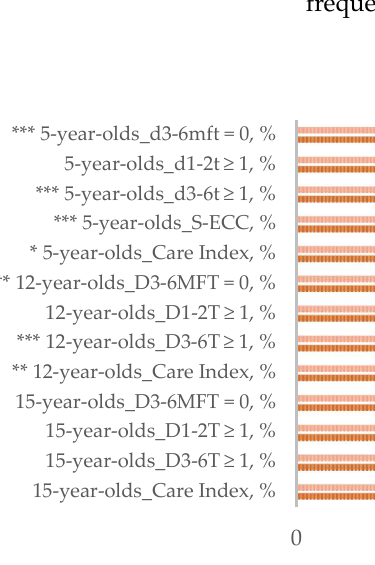
Figure 1. Caries prevalence of 5-, 12- and 15-year-old children and adolescents of immigrant origin in Greece, compared with their Greek age-mates. Percentage (%) with no caries experience at the defect level (d 3–6 mft/D 3–6 MFT = 0), percentage (%) with initial caries (d 1–2 t/D 1–2 T ≥ 1), percentage (%) in need of treatment (d 3–6 t/D 3–6 T ≥ 1), percentage (%) of 5-year-olds with severe early childhood caries (S-ECC) and Care Index (%) at the tooth level. * p ≤ 0.05, ** p ≤ 0.01 and *** p ≤ 0.001, as analysed by Pearson’s chi-square test and the Mann–Whitney U-test (for the Care Index analysis). Caries estimates of the Greek 5-, 12- and 15-year-olds were adapted from Diamanti et al. (2021) [11].